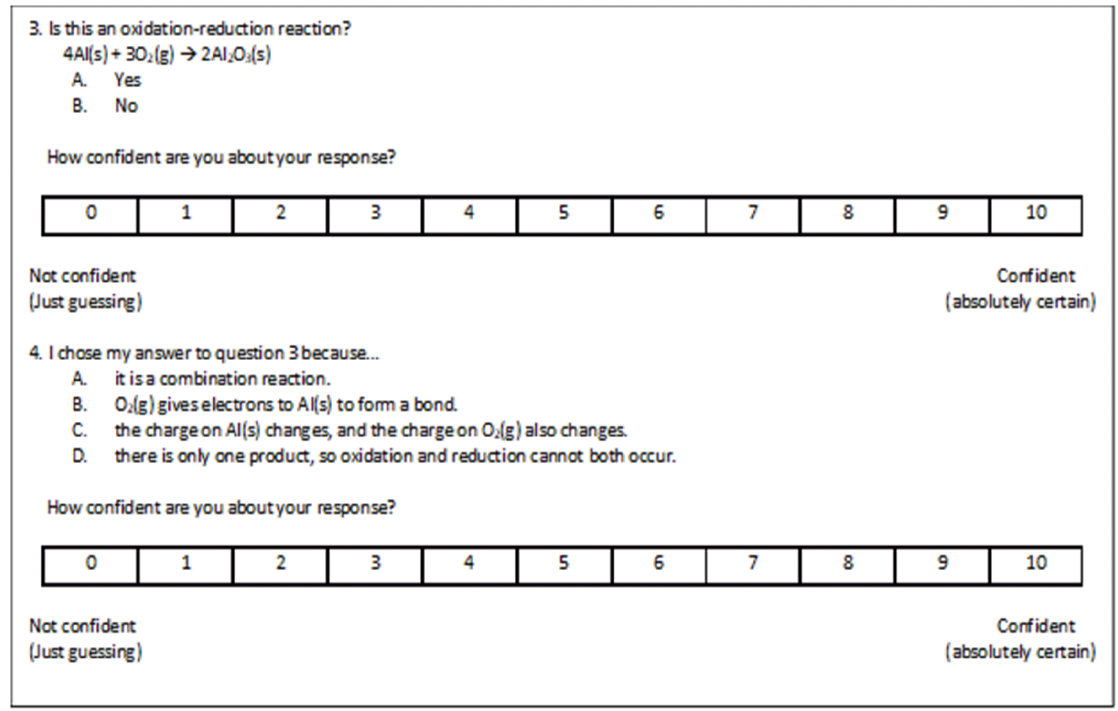
Figure 2. A two-tier item with the confidence scale on the Redox Concept